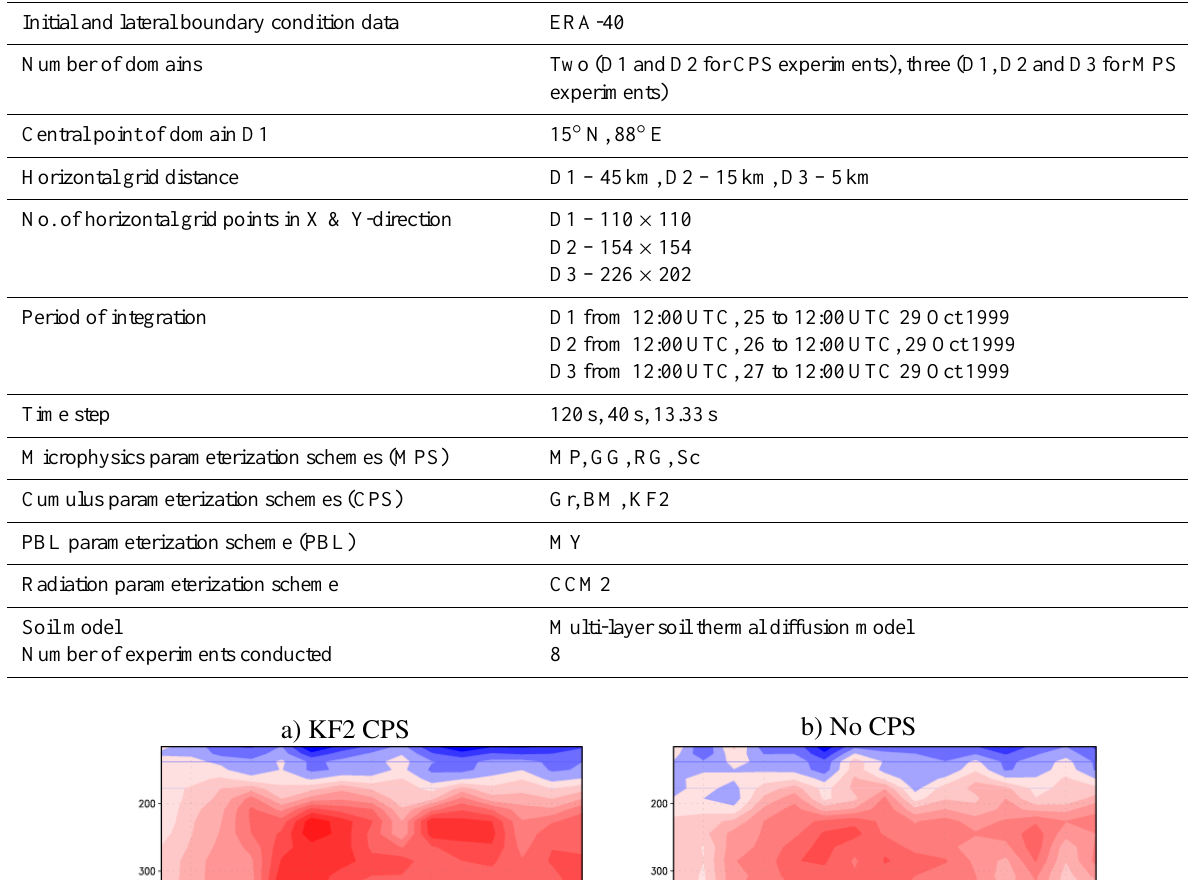
Table 1. Overview of MM5 model configuration for the experiments of sensitivity to the cumulus parameterization schemes (CPS) and microphysics parameterization schemes (MPS).